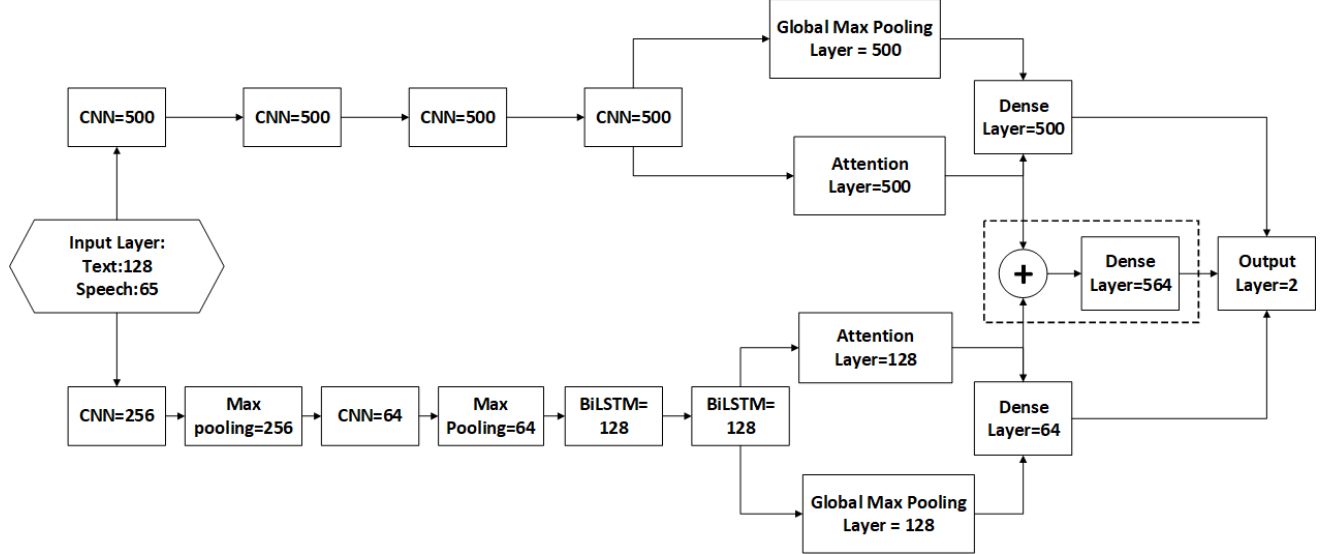
Figure 2. The Study Neural Networks Structure